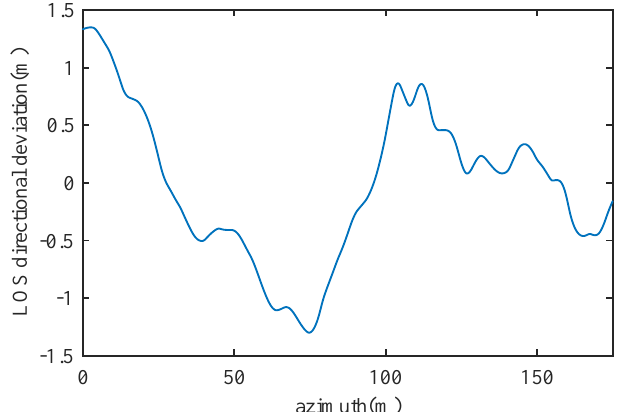
Figure 5. Trajectory deviation estimated with Doppler tracker.